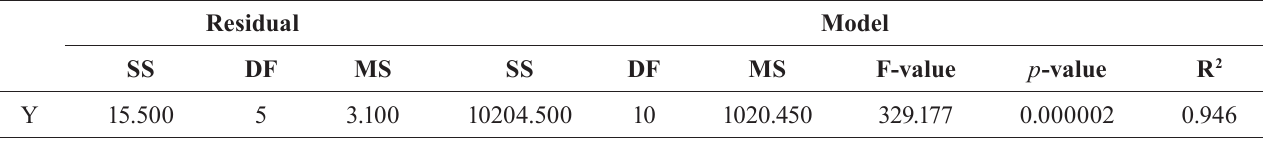
TABLE II - Analysis of variance (ANOVA) of modeled response